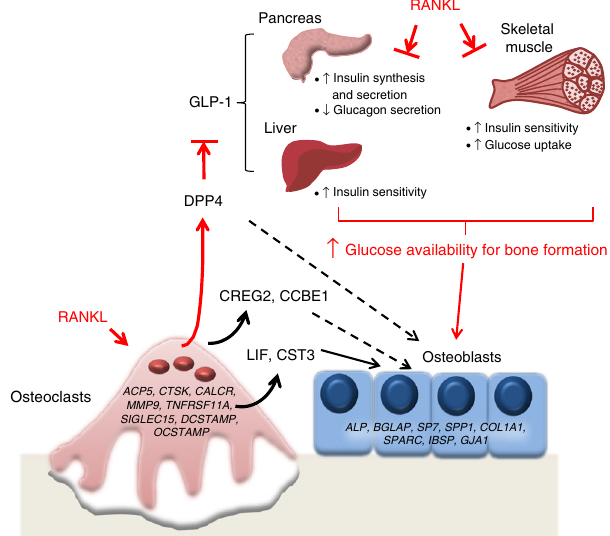
Fig. 6 Proposed mechanism for coupling of bone remodeling to energy metabolism. RANKL signaling in osteoclasts induces (directly or indirectly) the expression of key coupling factors, identi fi ed in our human study as LIF , CREG2 , CST3 , CCBE1 , and DPP4 (note that LIF and CST3 are known to have effects on osteoblasts and thus are likely osteoclast – osteoblast-coupling factors (solid arrows) 19,20,27 , whereas DPP4 , CREG2 , and CCBE1 are potential coupling factors identi fi ed by our study that require further characterization (dashed arrows)). Increases in circulating DPP4 lead to a decrease in GLP-1 levels, leading in turn to reduced insulin and increased glucagon secretion, resulting in hyperglycemia. These actions of RANKL- induced DPP4 appear to be synergistic with other effects of RANKL (denoted by red arrows and text) on glucose metabolism, which are to induce insulin resistance and increase circulating glucose levels. These fi ndings may be of particular interest in the context of previous fi ndings